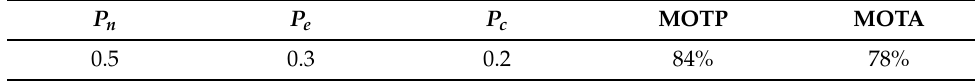
Table 4. The average MOTP and MOTA in a set of probabilities.